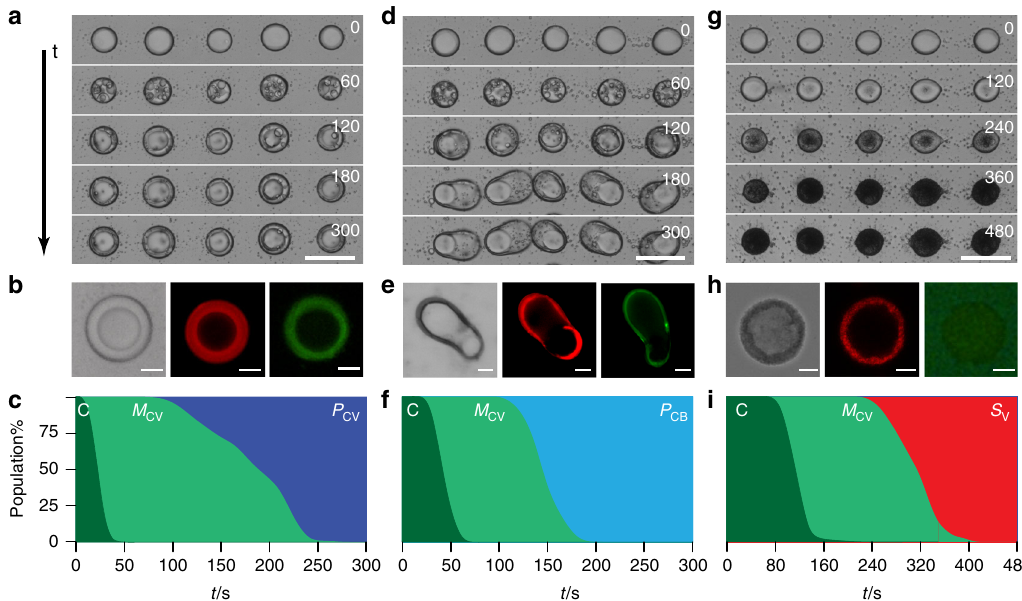
Fig. 1 Morphological transformations under equilibrium conditions. a Time ( t )-dependent optical microscopy images recorded from an acoustically formed array of PDDA/ATP coacervate micro-droplets at 0, 60, 120, 180 and 300 s after addition of a stirred solution of sodium phosphotungstate (POM, fi nal concentration 2 mM). Scale bar, 100 µ m. b Representative optical microscopy image (left), and RITC-PAH-doped (middle, red fl uorescence) and TNP-ATP- doped (right, green fl uorescence) fl uorescence microscopy images of a single-POM/coacervate vesicle. Scale bars, 20 µ m. c Corresponding area plot showing time-dependent changes in the numbers of native coacervate micro-droplets ( C , dark green), multi-compartmentalized coacervate vesicles ( M CV , light green) and spherical POM/coacervate vesicles ( P CV , dark blue) over 300 s. Changes in populations are shown as percentage of total. d – f )As for a – c ) but in the presence of a lower fi nal POM concentration (1 mM) showing transformation of the coacervate micro-droplets into POM/coacervate vesicles with balloon-like morphology ( P CB , light blue) via a series of M CV intermediates (see images at t = 60 s). Scale bars, 100 µ m ( d ) and 20 µ m ( e ). g – i As for a – c but without POM and in the presence of SDS micelles ( fi nal concentration, 20 mM). Optical microscopy images are recorded at 0, 120, 240, 360 and 480 s ( g ). The coacervate droplets transform into ATP-depleted SDS/PDDA vesicles ( S V ) ( h ). Transformation to S V (red area in ( i )) occurs sequentially over 300 s via a M CV intermediate. Scale bars, 100 µ m ( g ) and 5 µ m ( h ). Source data are provided as a Source Data fi